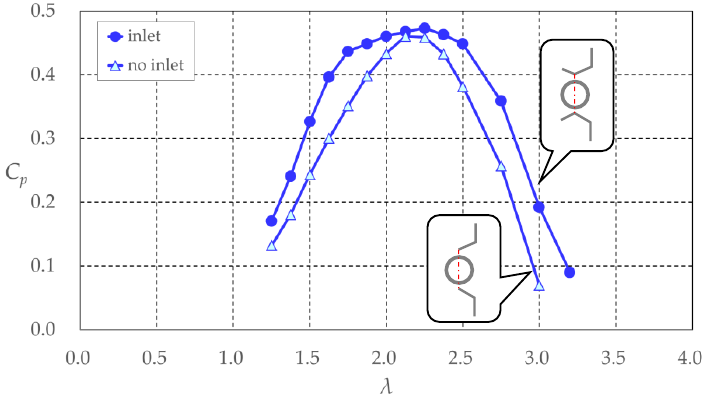
Figure 8. Effect of the inlet of the wind lens on power coefficient C p .